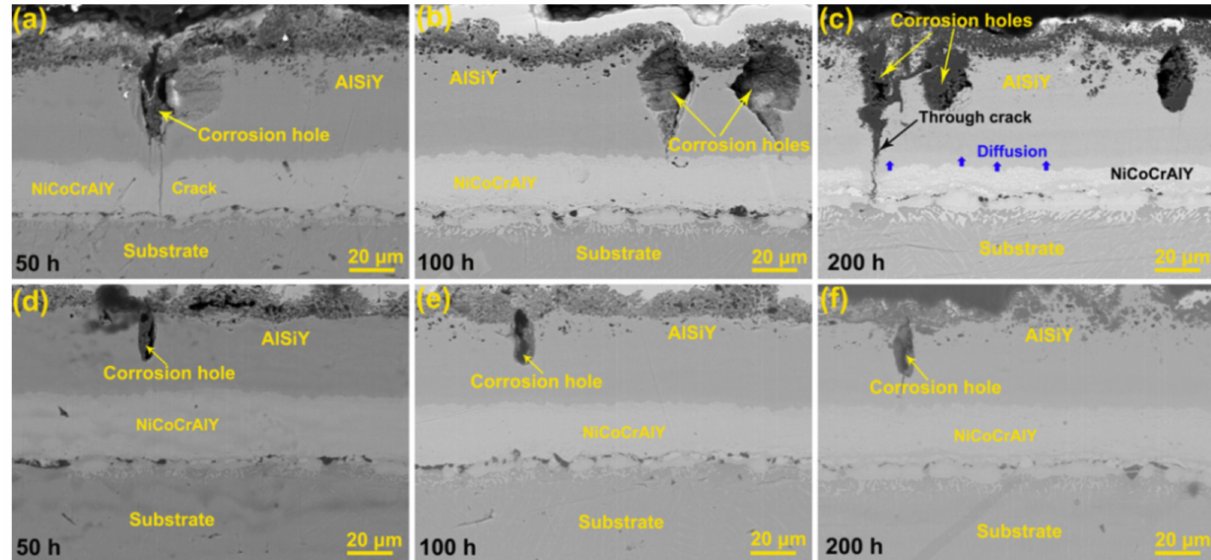
Figure 5. SEM cross-sectional images of the corroded samples E1 ( a – c ) and E2 ( d – f